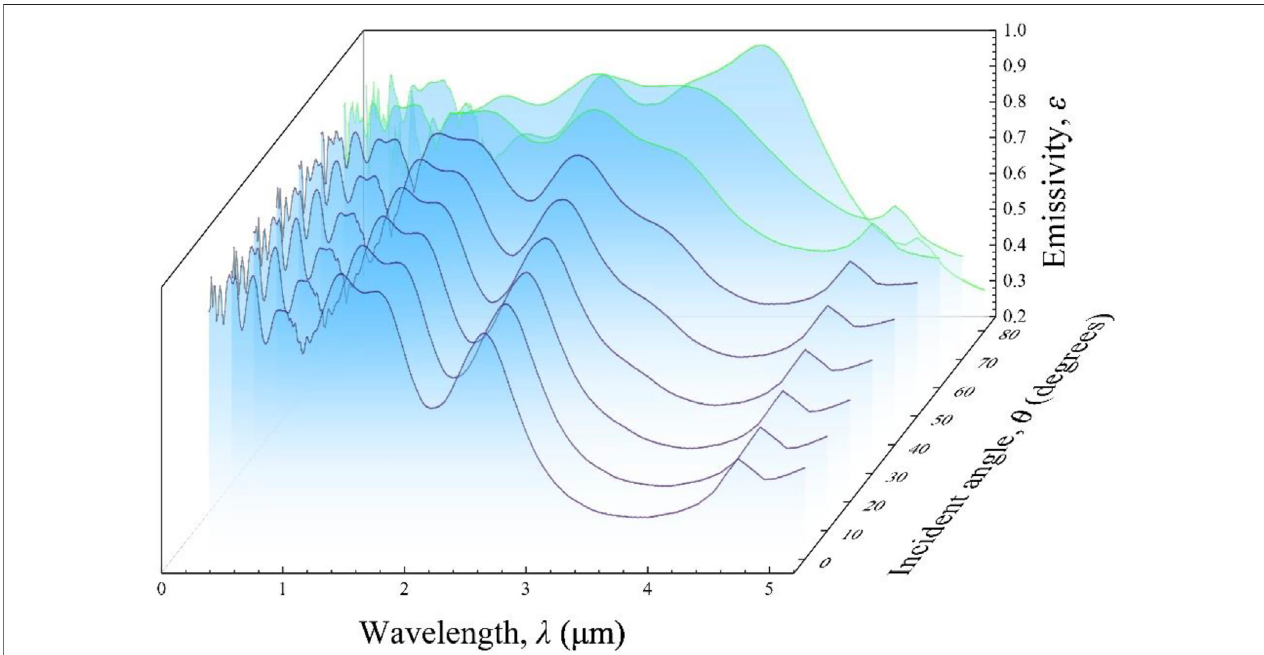
FIGURE 2 | The spectral emissivity of the proposed multilayer fi lm as a function of incident angle.